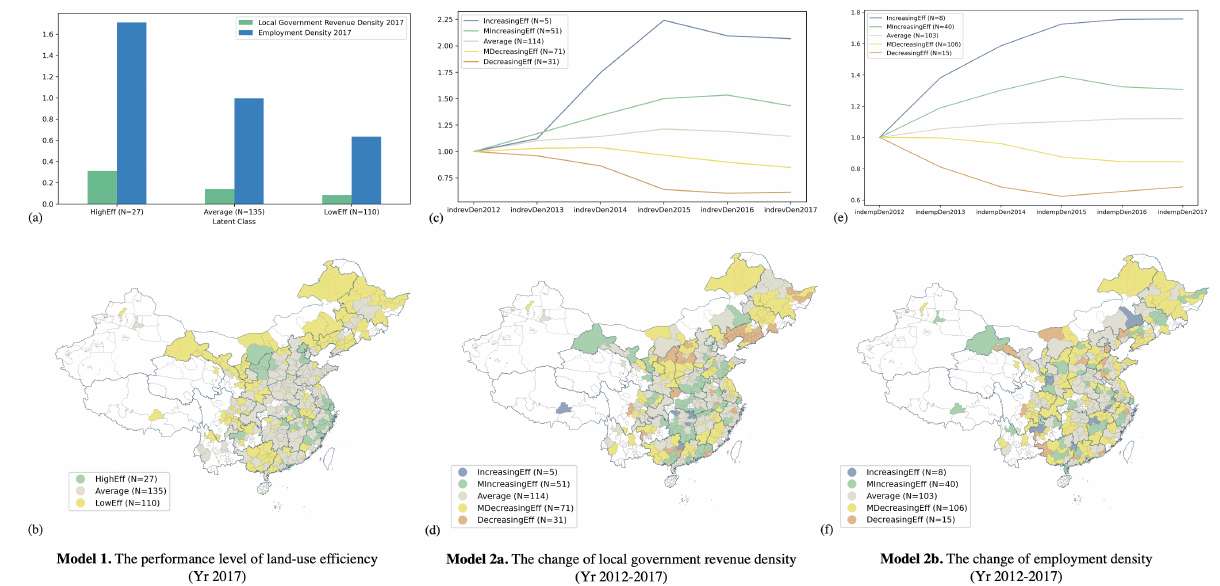
Figure 3. The LCA results of Model 1, Model 2a, Model